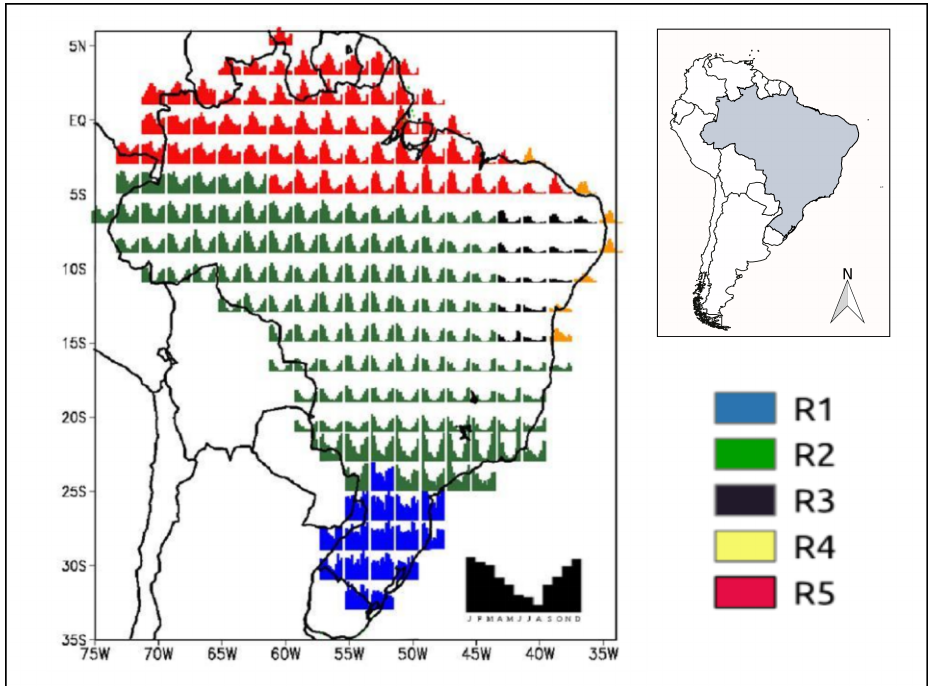
Figure 1. The five regions of Brazil according to climatological rainfall regime. Southern Brazil (R1-blue), central region (R2-green), northeastern (R3-black), northeast coast (R4-yellow), and north Brazil (R5-red), adapted from